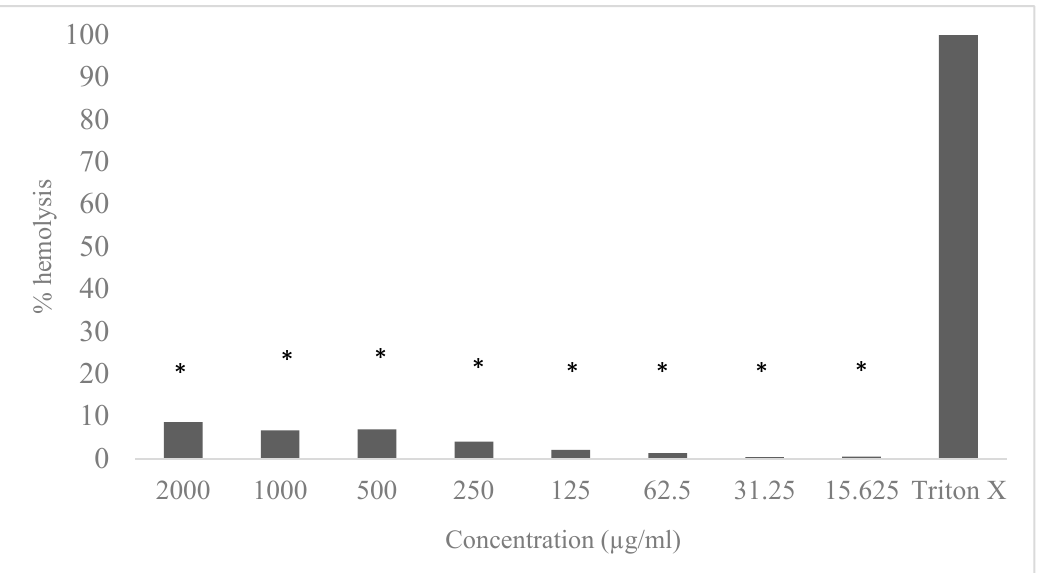
Figure 2. Hemolytic capacity of Jucá extract at di ff erent concentrations. * Statistically signi fi cant di ff erences in relation to positive control Triton X ( p < 0.05).